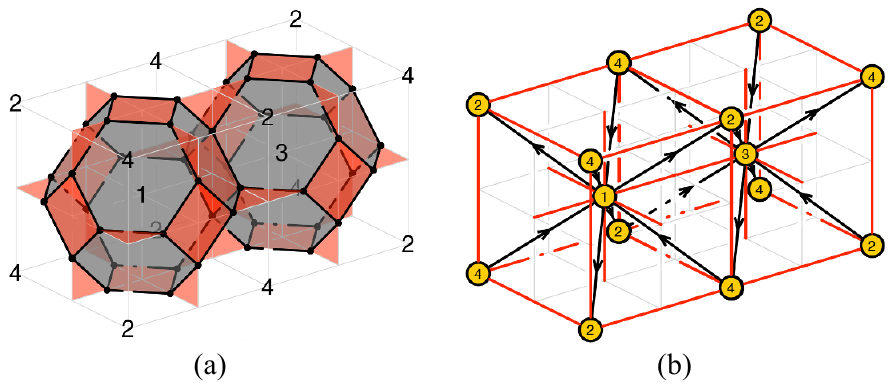
Figure 2. a) Brane brick mode and b) dual periodic quiver for local CP 3